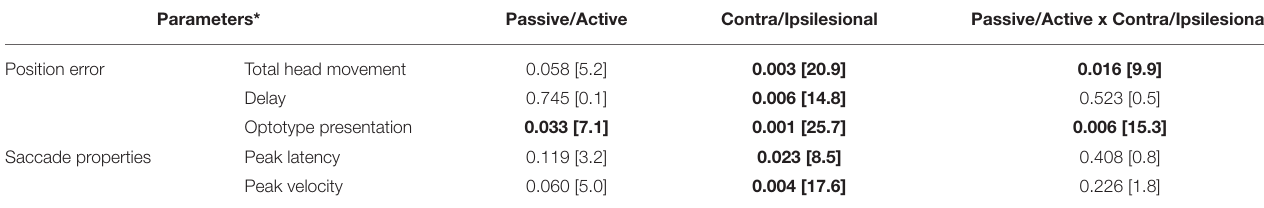
TABLE 1 | Repeated measures GLM ANOVA of anteroposterior spectral power with main factors “active vs. passive” and “contralesional vs. ipsilesional” and their factor interactions. Parameters* Passive/Active Contra/Ipsilesional Passive/Active x Contra/Ipsilesional Position error Total head movement 0.058 [5.2] 0.003 [20.9] 0.016 [9.9] Delay 0.745 [0.1] Optotype presentation 0.033 [7.1] 0.001 [25.7] 0.006 [15.3] Peak